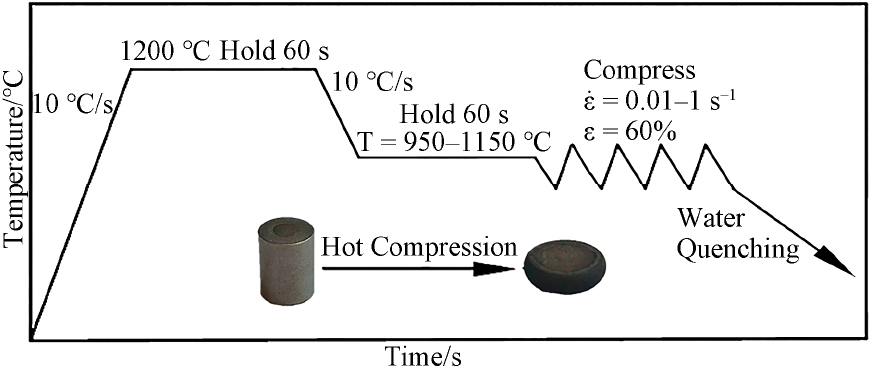
Figure 1. The high-temperature compression procedure. After the high-temperature compression experiments, the samples were cut into two halves along the axial direction and subjected to microstructural characterization using the EBSD technique. An electrolysis experiment was performed in a solution of 10:1 ethanol and perchloric acid at a voltage of 30 V for 20 s. The EBSD scans with a